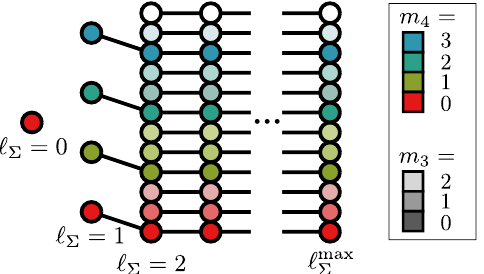
( 1 ) ≡ m and m 3 4 3